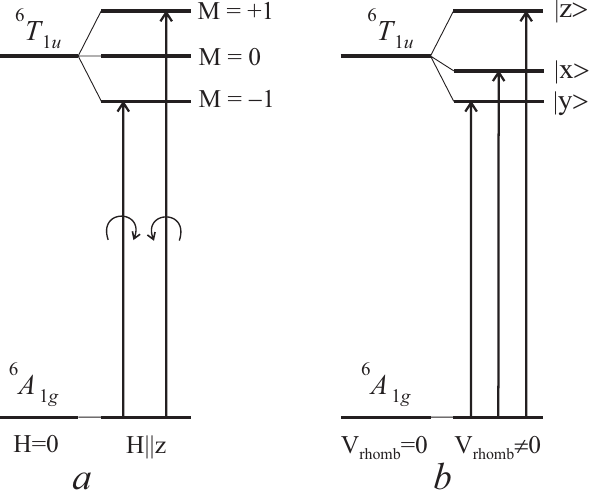
Figure 3. An illustration of the nature of circular and linear birefringence due to a splitting mechanism: ( a ) schematic for the dipole allowed CT transitions 6 A 1 g → 6 T 1 u for the light with right and left circular polarization under external magnetic field and orbital Zeeman splitting; ( b ) schematic for the CT transitions 6 A 1 g → 6 T 1 u for the light with a linear polarization in a low-symmetry (rhombic) crystal field and Stark splitting for excited 6 T 1 u state. Note that we are dealing with final current ( a ) and currentless ( b ) states,